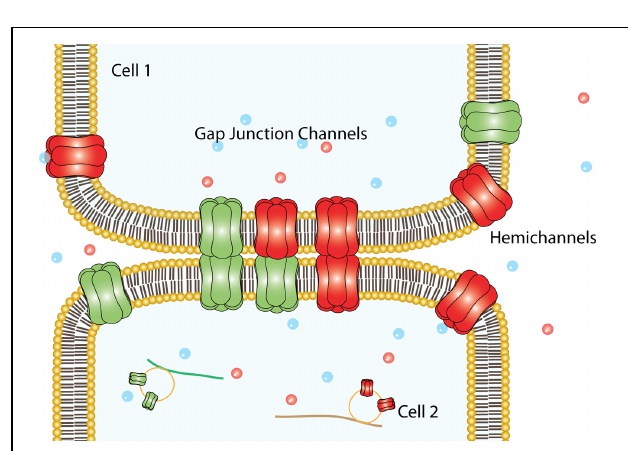
FIGURE 1 | Topology of connexin (Cx) at the plasma membrane. Cartoon depicting the plasma membrane topology shared by all Cx isoforms, which includes four transmembrane (TM) segments that are connected by two extracellular loops (ELs) and one intracellular loop (IL). The amino terminal (NT) and carboxi terminal (CT) segments of each hemichannel face the cytoplasm. The length of the NT and CT segments is not intended to represent any particular Cx isoform.